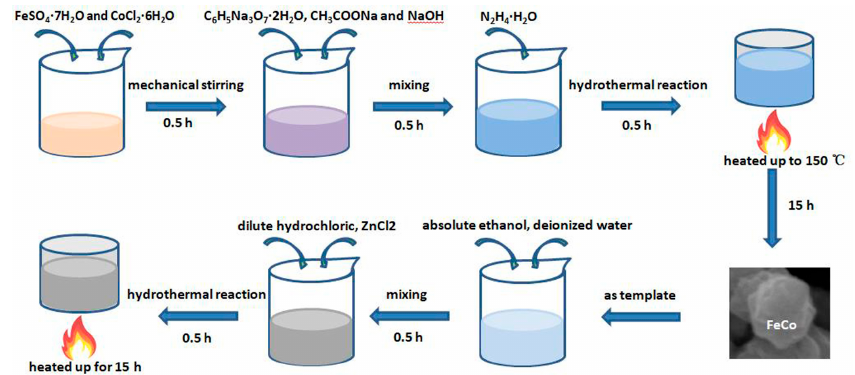
Figure 1. The schematic of the synthetic progress for the FeCo/ZnO composites.